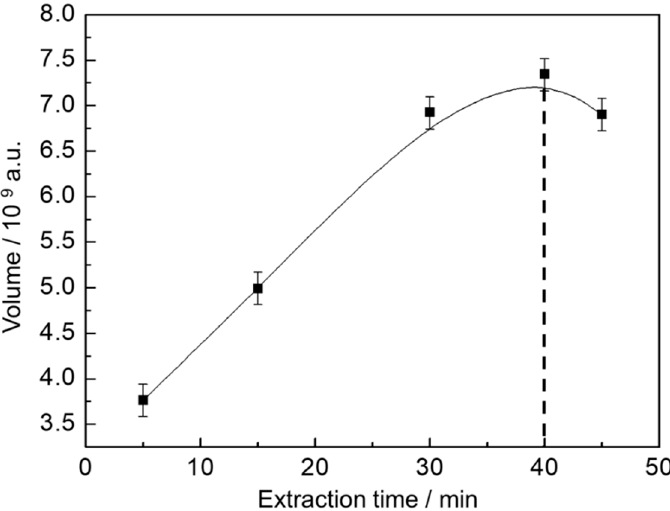
Figure 1. Extraction profile of volatile and semi-volatile organic compounds (VOC) from beer. The response is presented as the sum of the peak volumes from the GC × GC chromatogram.